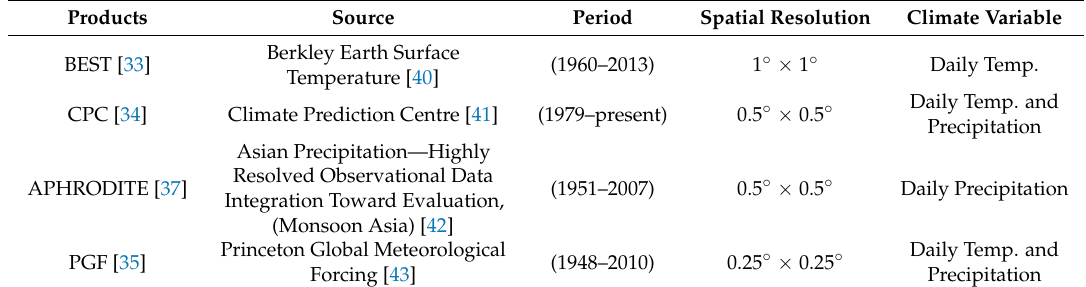
Table 1. The description of the gridded datasets used in the study.